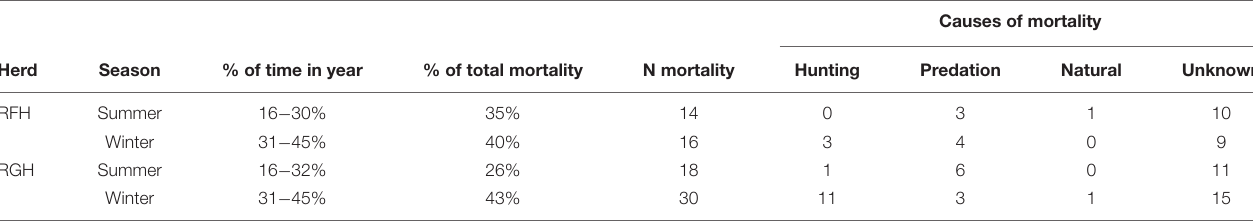
TABLE 2 | Descriptive statistics of migratory caribou mortalities during summer and winter of 2009 − 2016 for the Rivière-aux-Feuilles (RFH) and Rivière-George (RGH) herds in northern Québec and Labrador, Canada.